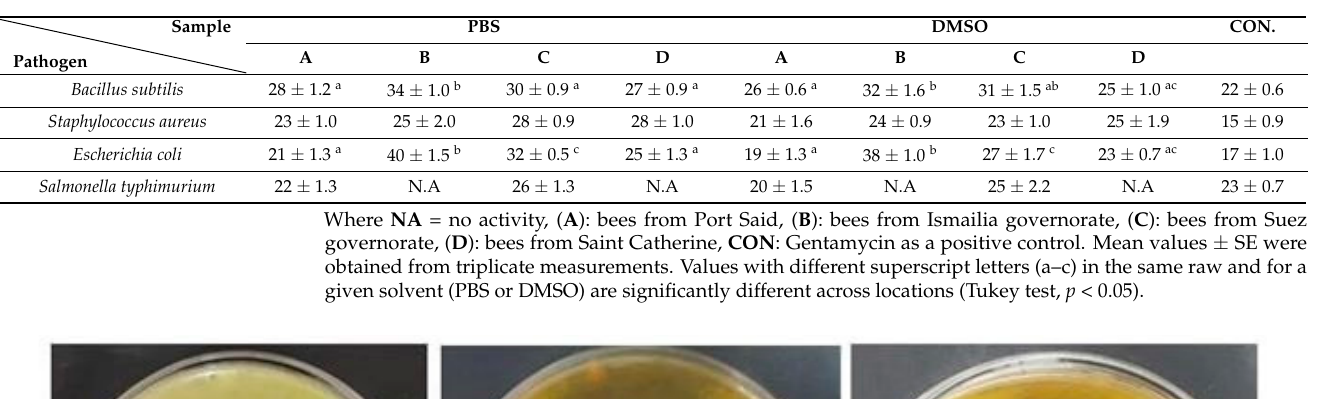
Table 3. Inhibition zone (mm) of honey bee hemolymph extracted in PBS or DMSO on various types of bacteria ( Bacillus subtilis, Staphylococcus aureus, Escherichia coli and Salmonella typhimurium ). Sample PBS DMSO CON. A B Pathogen